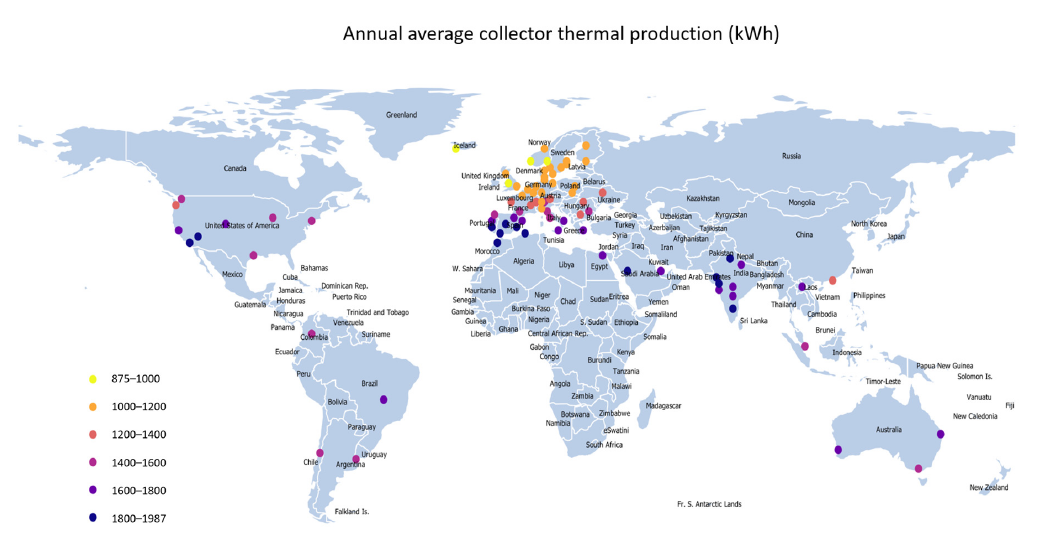
Figure 7. Annual average collector thermal performance.